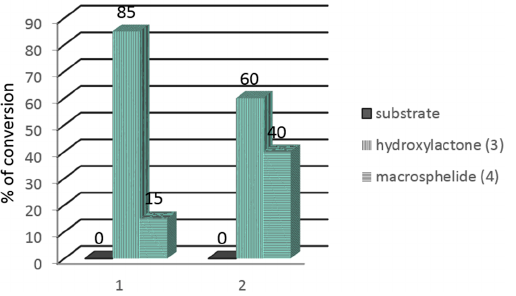
Figure 1. Results of the preparative biotransformation of bromo- and iodolactones 1 and 2 (in %) according to GC-FID.